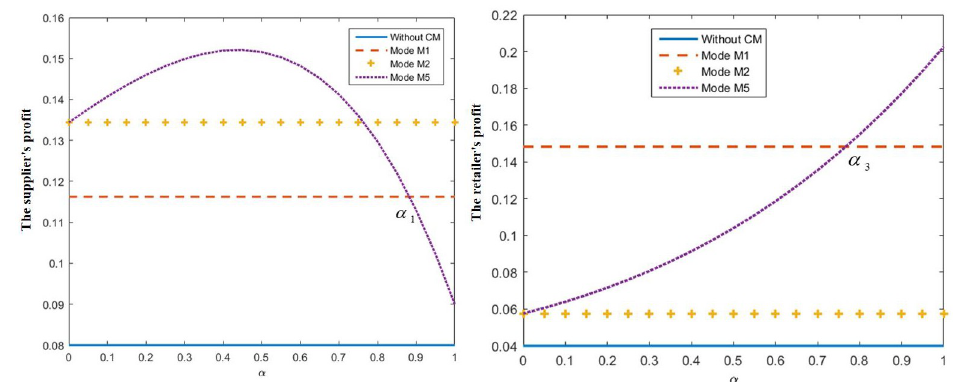
Fig 3. The influence of α on the supplier’s and retailer’s